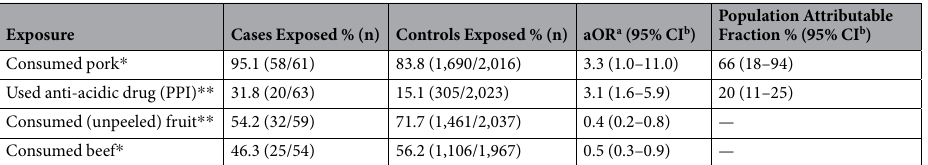
Table 5. Factors positively associated (risk factors) and factors negatively associated with Campylobacter coli infections in age group ≥ 15 years. Case-control study, Germany, 2011–2014. The proportion of exposed cases and controls is based on the number of cases and controls with complete answers in univariable analysis (without adjustment for age group, sex, federal state). Adjusted odds ratios (aOR) were determined in multivariable logistic regression analysis (adjusted for age group (15–29 years, 30–59 years, ≥ 60 years), federal state, sex; 50 cases and 1,786 controls with complete answers for all variables in the final model). a Adjusted odds ratio. b Confidence interval. * Indicates P < 0.05. ** Indicates P <